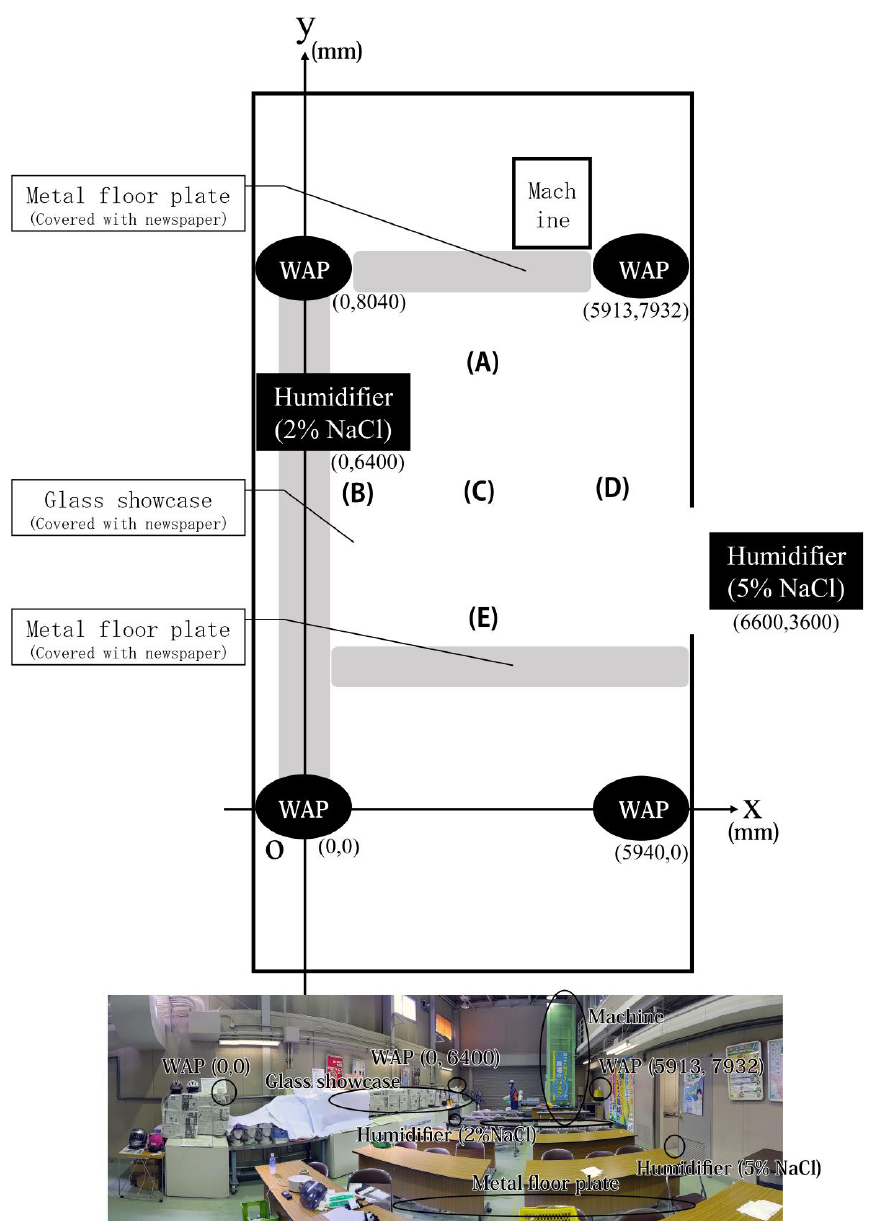
Figure 1. Overview and photographs of the model factory. The schematic diagram indicates the positions of the measure- ment points for accuracy verification, the coordinates measured by the laser rangefinder are: (A) (2900, 6500); (B) (1900, 3000); (C) (3000, 3200); (D) (5700, 2800); and (E) (3100, 800) (WAP denotes the Wi-Fi access point). The photo below was taken from, approximately the coordinates (3000,0). The humidifier is not installed; the WAP installed at the coordinates (5940, 0) is out of the field of view of the camera; the metal floor near point (A) is hidden from view in the photo; the metal floor near point (E) is roughly in the position indicated. The glass showcase is covered with paper or cloth, and the metal floor is not